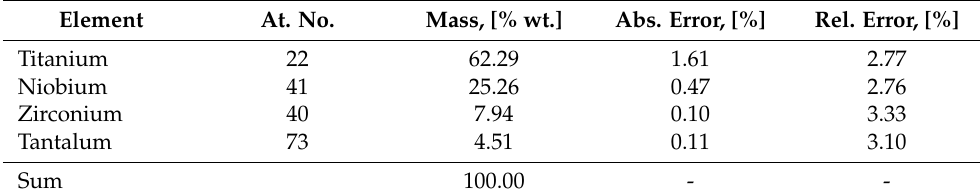
Figure 3. SEM-BSE image of the AR TNTZ alloys microstructure ( a ); SEM-EDS colorized maps. showing the main alloying elements distribution ( b ); EDS spectra of AR TNTZ alloy ( c ).